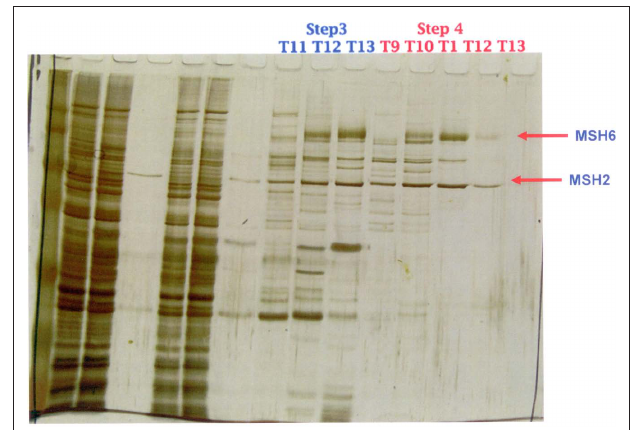
Figure 5 | SDS-PAge gel of Purification results for MutSa (MSH2 –